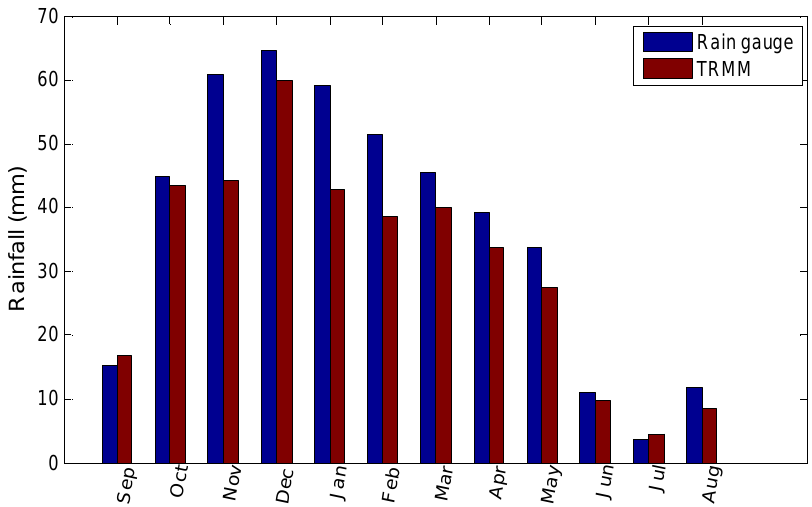
Figure 8. Annual cycle of rainfall obtained from Tropical Rainfall Measurement Mission (TRMM) data and rain gauges for the period of 1998–2010.